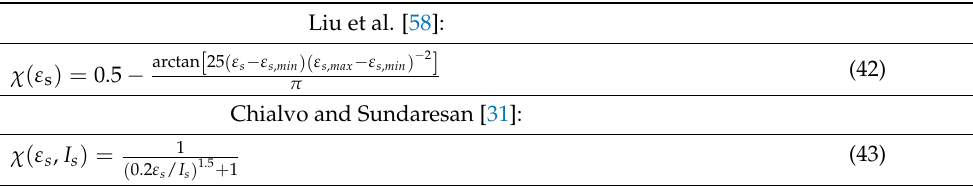
Table 10. Blending function for kinetic-collisional law and frictional law. Liu et al.